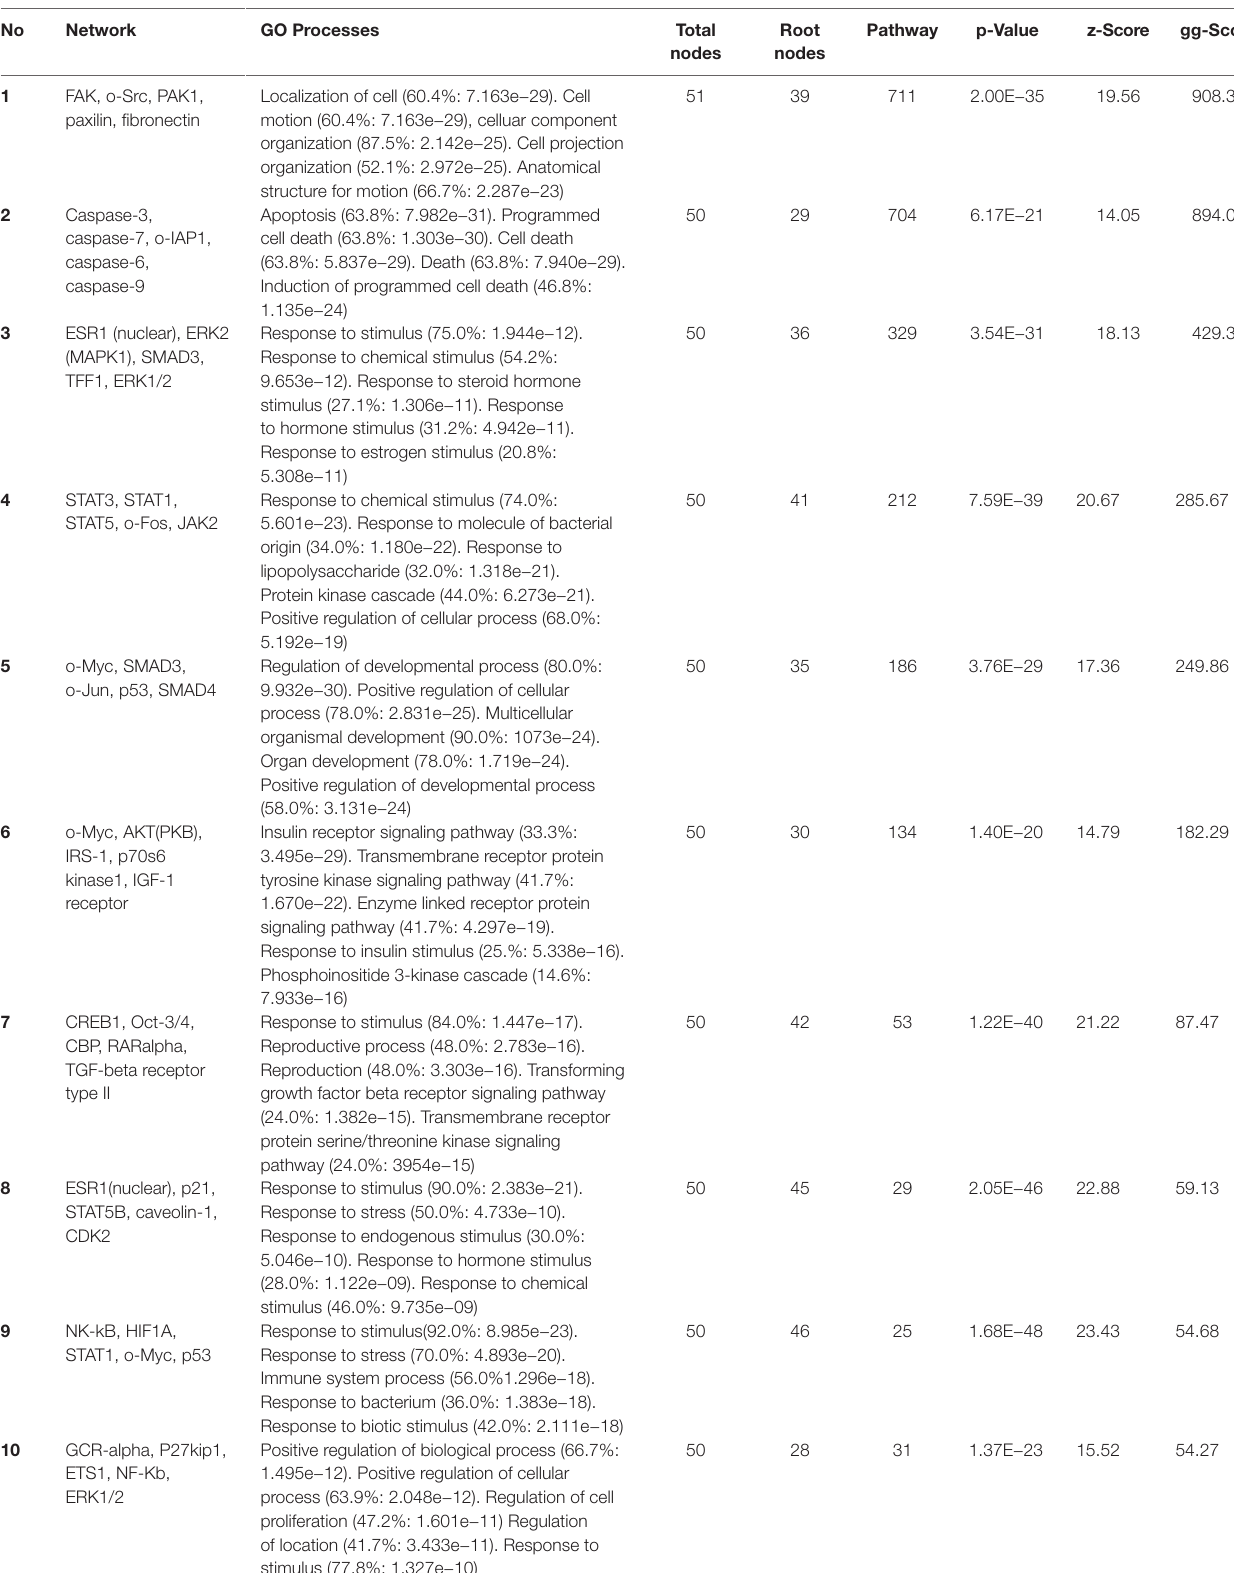
TABle 1 | Network and Gene Ontology process of differential expressed